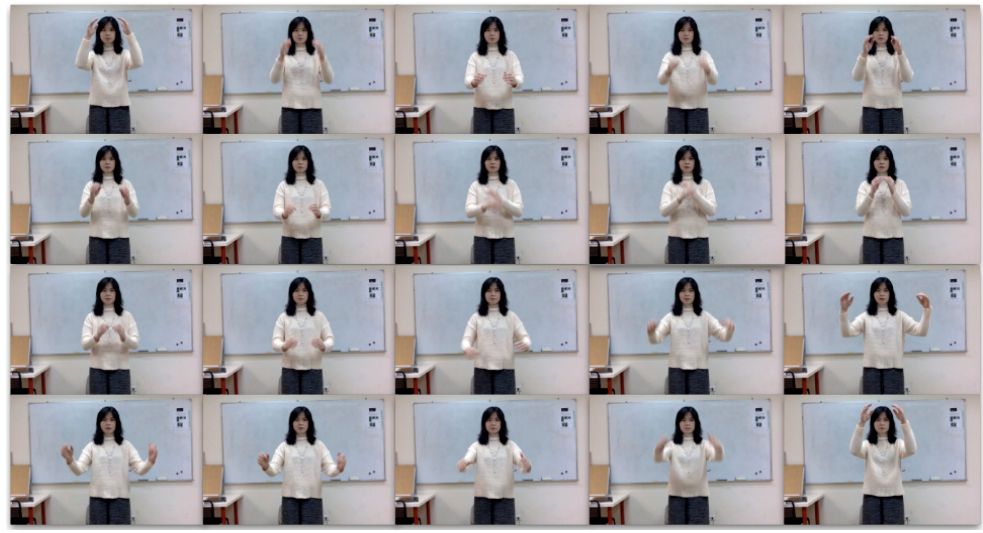
Figure 13. Examples of a quad (4/4) gesture.